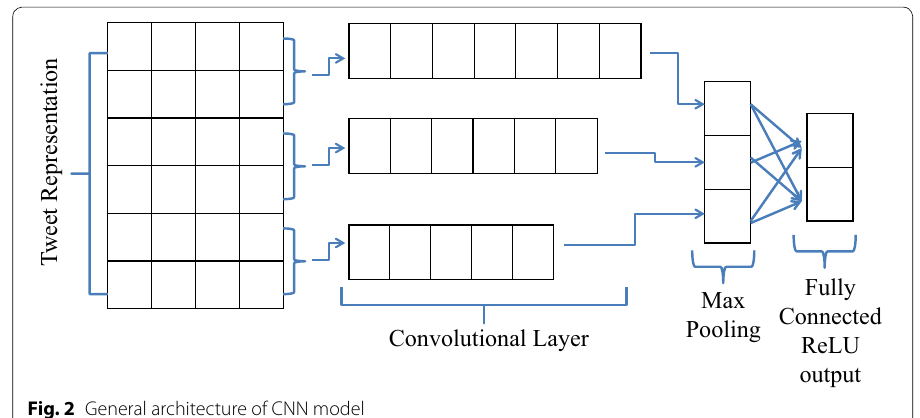
Fig. 2 General architecture of CNN